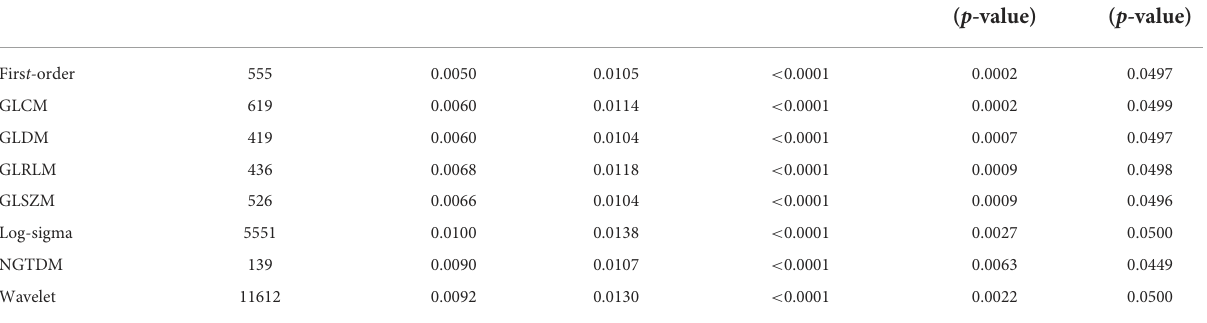
TABLE 4 The statistics of significant Radiomincs features groups.